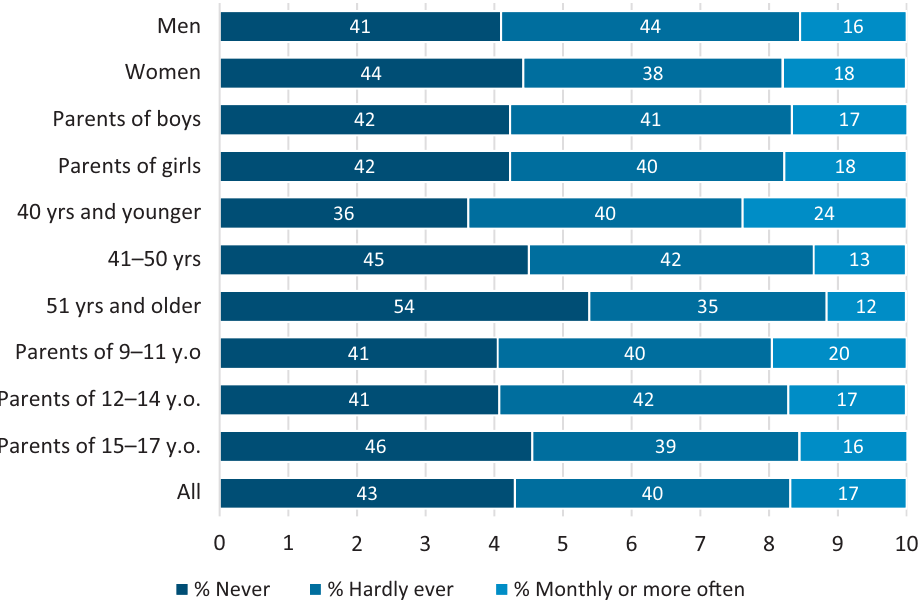
Figure 1. How often do you share/post/blog photos/videos of your child online? By gender and age of parent and child. Notes: Data from all countries; parent gender n = 5,461, gender of child n = 5,265, parent age n = 5,424, age of child n = 5,286.